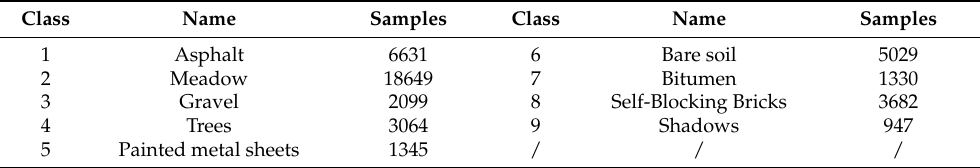
Table 2. Nine ground-truth classes of the Pavia University data Figure 3. ( a ) False ‐ color image and ( b ) ground truth map of the Pavia University data set.